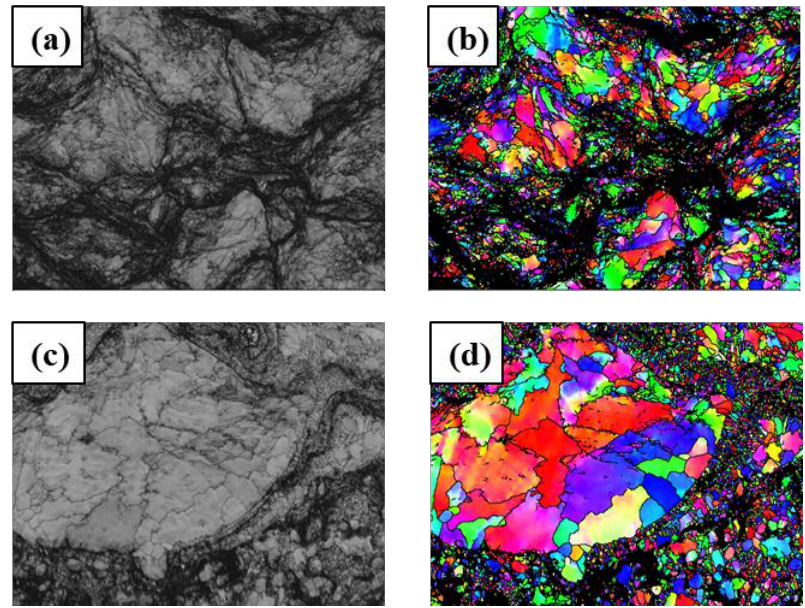
Figure 9. Image quality, phase structure and particle size of electron backscatter diffraction patterns of high-entropy alloy coatings. ( a , b ) CS coatings; ( c , d ) HVOF coatings. Figure 10 are TEM-selected area diffraction patterns of CS and HVOF high-entropy alloy coatings. No phase transition occurs for the CS coating, and it is a typical FCC phase. Selection of crystalline phase and twins along the band axis [011] and [0-1-1] electron diffraction patterns proved the existence of a twin structure (Figure 10c,d).